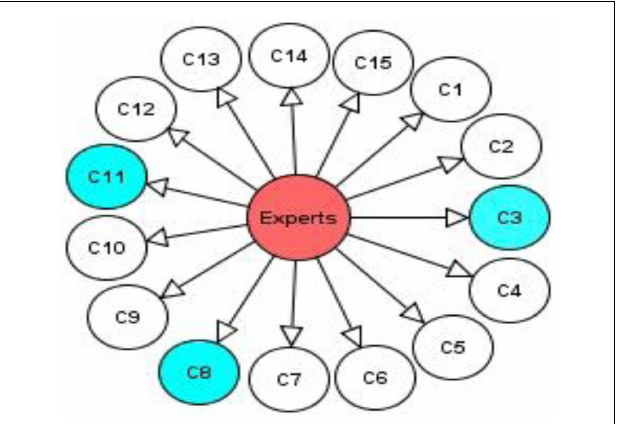
FIGURE 4 | Selection of criteria by using BN .